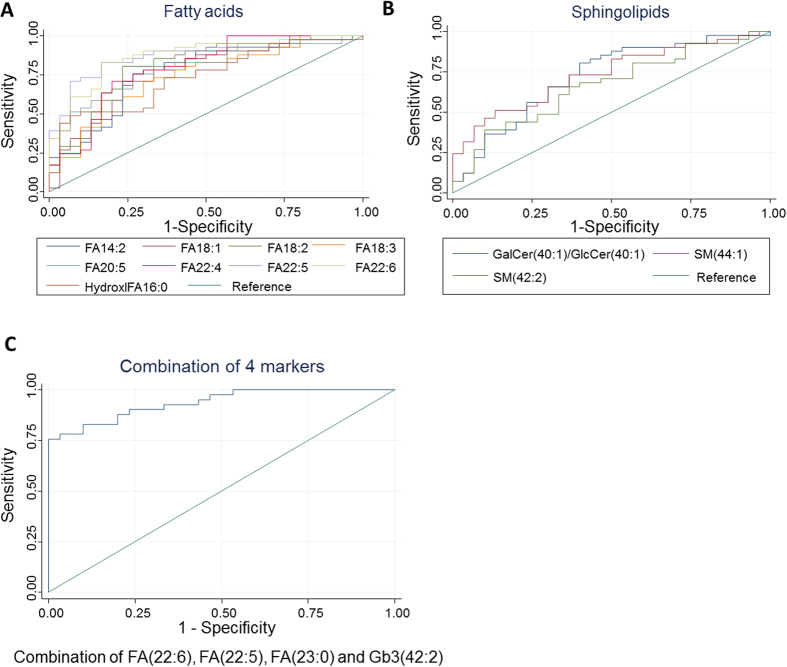
Diagnostic performance of lipid markers in discriminating pleural effusion from malignant NSCLC patients (n = 41) from benign subjects (n = 30).ROC curves of malignant versus benign subjects for individual PE lipid markers in the class of (A) fatty acids (B) sphingolipids. (C) ROC curves of malignant versus benign subjects for an optimal combination of 4 lipid malignancy markers from SVM modelling.